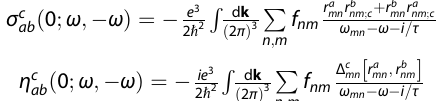
Fig. 3a. Like PTMDs 27 , the metal d -orbitals and chalcogen p - orbitals are inverted around the Γ point, and the inverted bandgap is around 0.8 eV. The fundamental bandgaps are along the Γ – Y line (± Λ point, inset of Fig. 3b) with a magnitude of E g ≈ 4 meV. We fi nd that the fundamental bandgaps of all six 1T ′ JTMDs lie in the